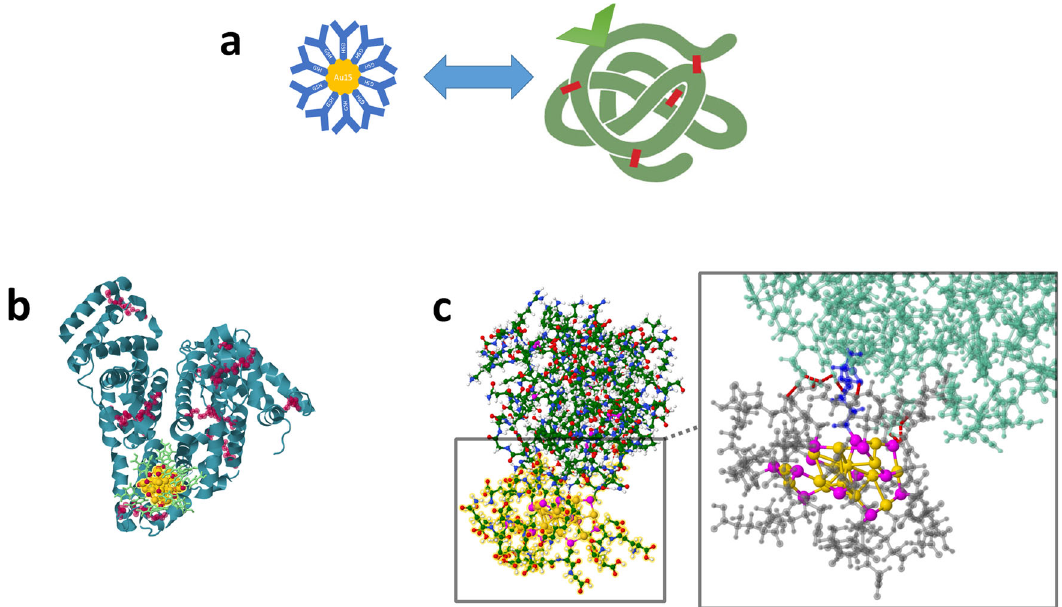
Fig. 1 Dual opportunity of the bio-NC interface: proteins can be used for protecting NCs, and the surface ligands of NCs may interact with proteins. a Schematics of ligand protected metal NCs and proteins leading to the bio-NC interface. Dual role of the bio-NC interface: b proteins can be used as templates for protecting NCs and c surface ligands of NCs may be functionalized to present some speci fi c interactions with